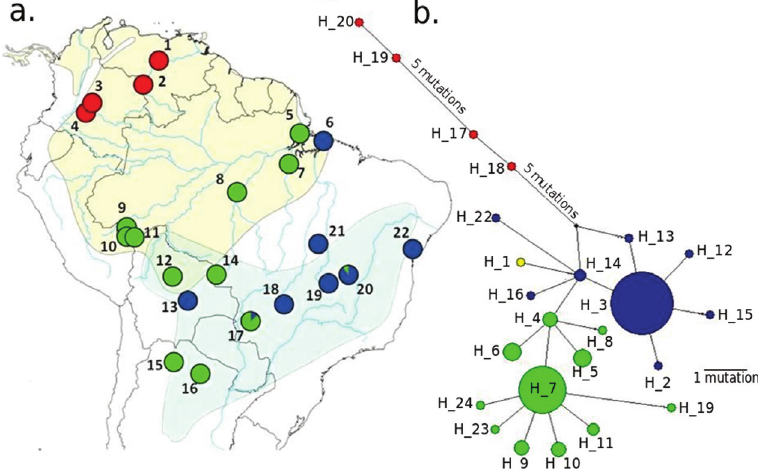
Figure 4 - Map and haplotype network. (a) Map showing the distribution of A. aestiva (light blue) and A. ochrocephala (yellow). Circles and numbers in- dicate the localities sampled (Table S3). Circle colors represent the frequency of observed lineages on the haplotype network for each locality. (b) Haplotype network with colors representing the three main lineages. Red - A. ochrocephala ; Green - mixed population of A. ochrocephala and A. aestiva , withthemajoritybeingfromtheformer;Blue-mixedpopulationof A.aestiva and A.ochrocephala ,withthemajoritybeingfromtheformer.TheCOIse- quence from the individual whose mitogenome was described (FVVF132) is in